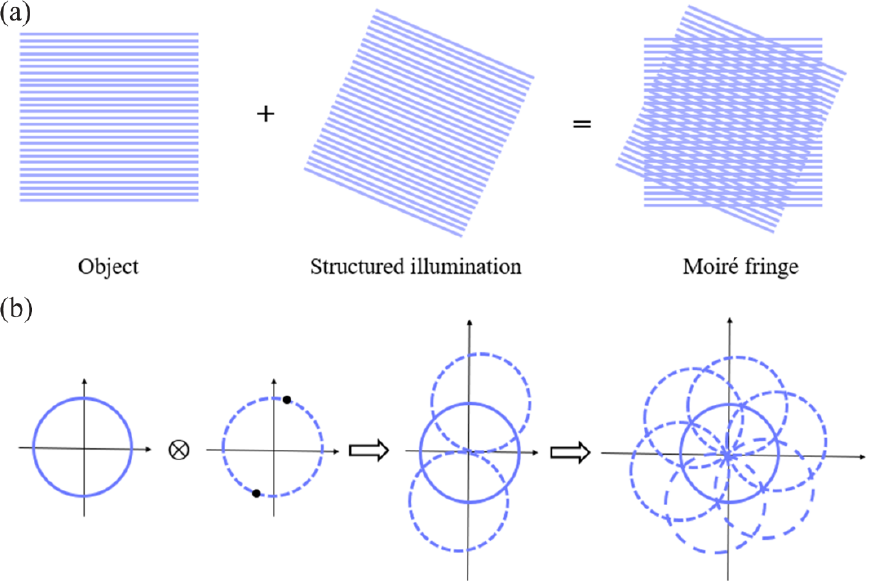
Figure 5. Schematic diagram of SIM principle: ( a ) generation of moiré fringes; ( b ) implementation of two-dimensional spatial frequency expansion.